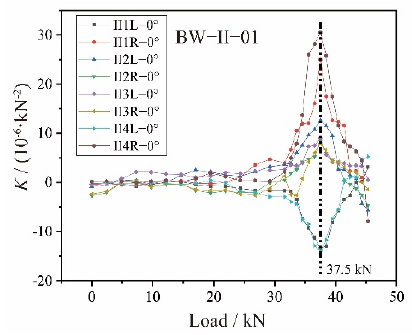
Figure 12. The experimental K -load curves of the different strain measurement points on the BW-II-01 PWF composite beam.